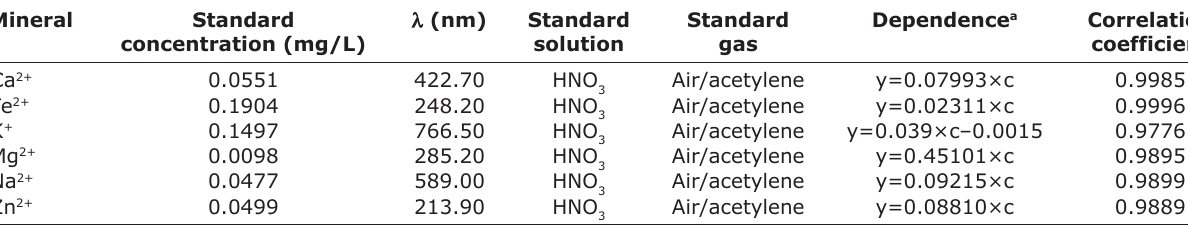
Table-2: Characteristics of the calibration curves of minerals. Mineral